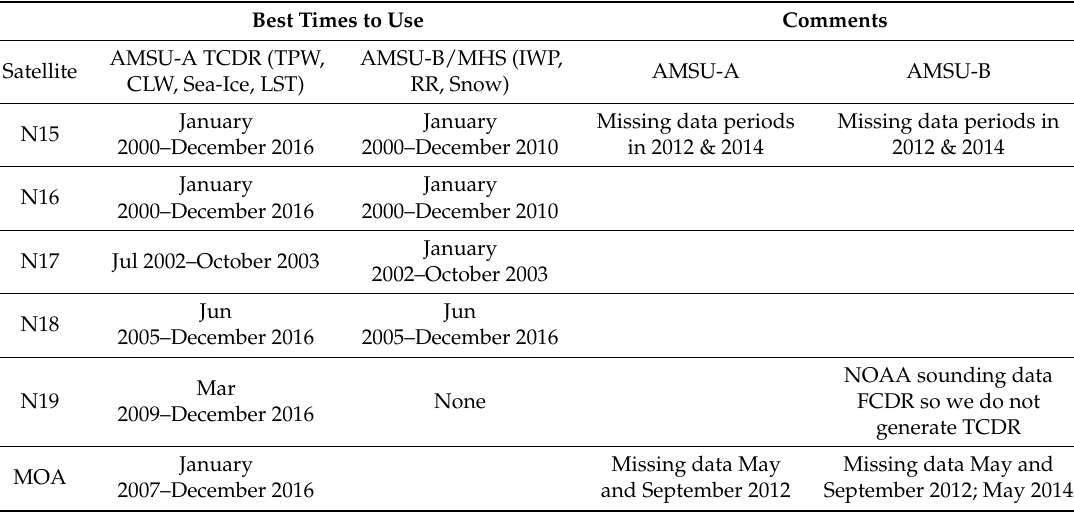
Table 2. List of best times to use the various satellite products.